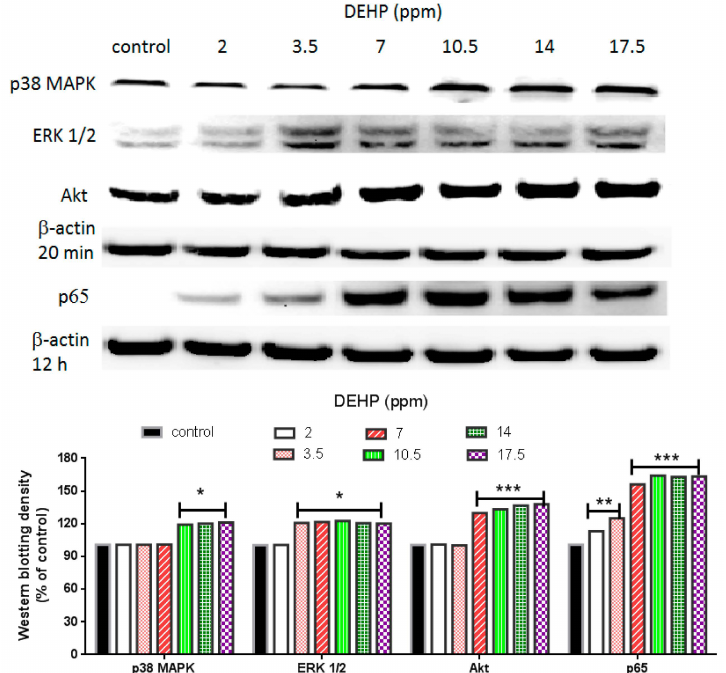
Figure 3. Effects of DEHP on phosphorylated p38 MAPK, phosphorylated ERK1/2, phosphorylated Akt, and NF- κ B (p65) protein expression. VSMC ( n ě 3) were treated with DEHP (concentrations between 2 and 17.5 ppm) for 20 min (p38 MAPK, ERK1/2, and Akt) or 12 h (NF- κ B) prior to protein extraction. Phosphorylated p38 MAPK, phosphorylated ERK1/2, phosphorylated Akt, and NF- κ B (p65)